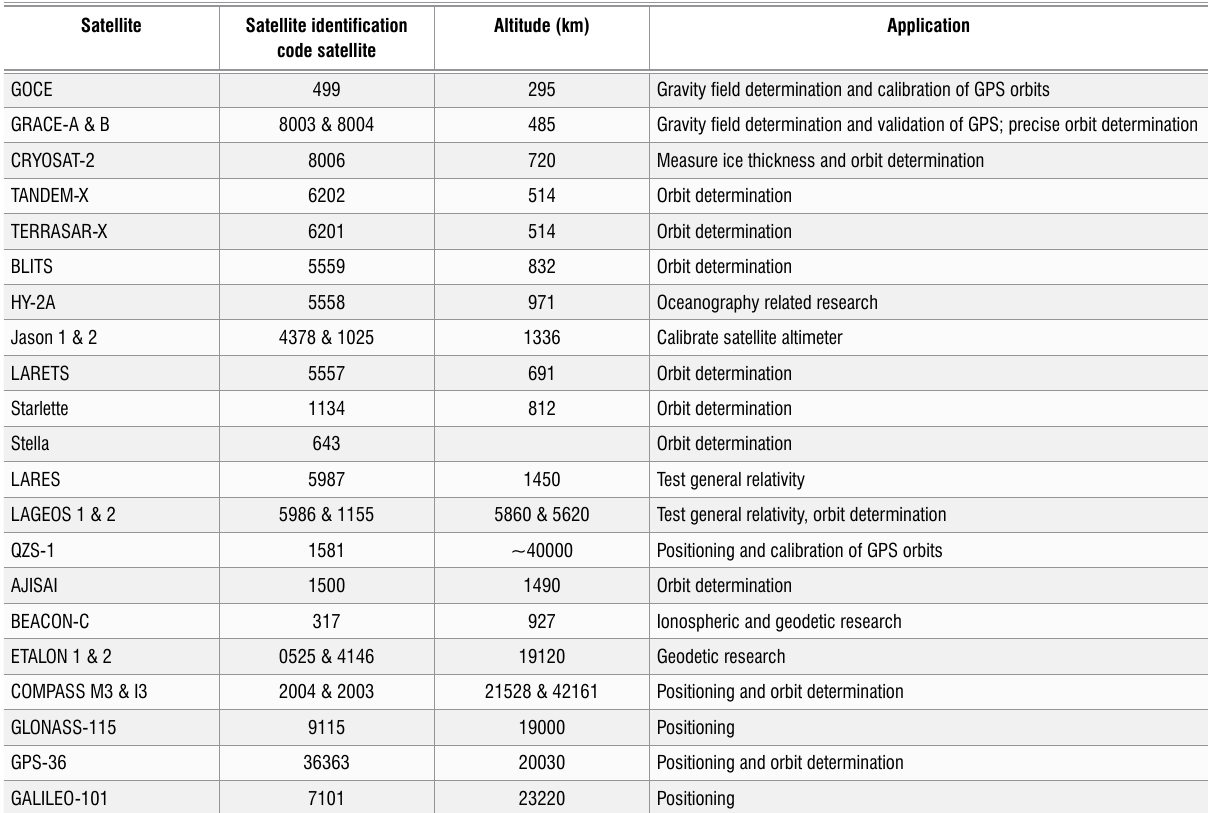
Table 5: Priorities of satellites tracked by MOBLAS-6 system